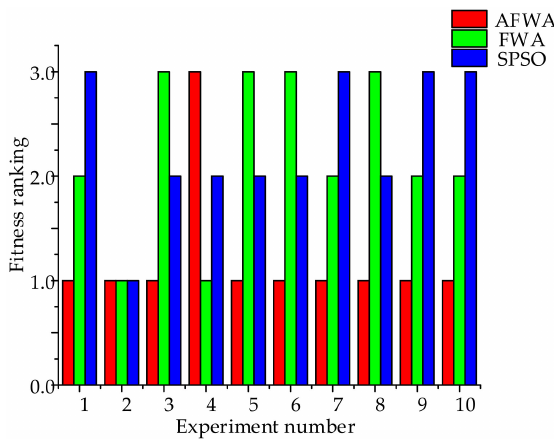
Figure 12. Algorithm fitness ranking of the third